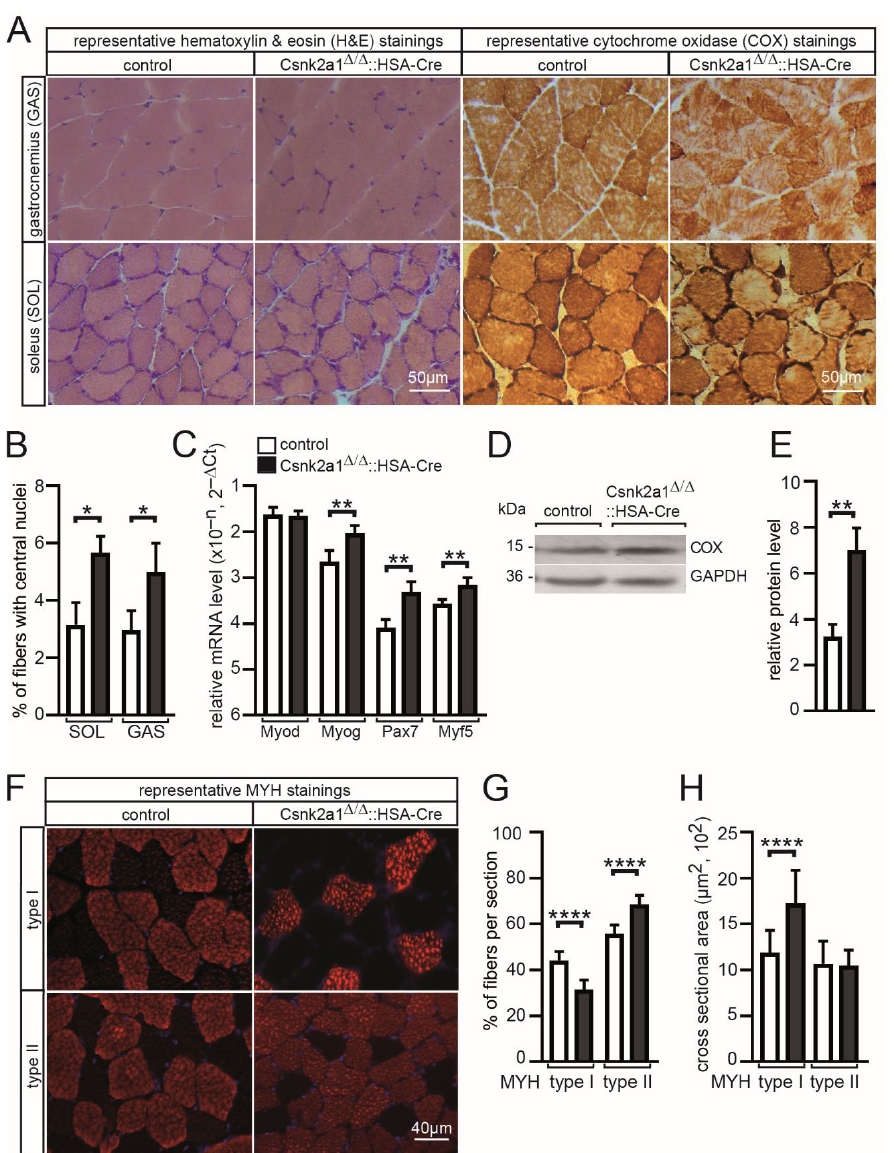
Figure 3. Increased number of central nuclei, cytochrome oxidase, and several myogenic markers are accompanied by changes in muscle fiber distribution and cross-sectional areas in conditional Csnk2a1 knockout mice. ( A ) Hematoxylin/eosin (H&E) and cytochrome oxidase (COX) stains of hind limb muscle cross-sections of control and conditional Csnk2a1 knockout mice. ( B ) Graph presents the number of central nuclei as counted in a representative number of cross-sections of control and conditional Csnk2a1 knockout mice. ( C ) Graph summarizes transcript amounts of myogenic markers Myod1, Myog, Pax7, and Myf5 in tibialis anterior muscle of control and conditional Csnk2a1 knockout mice. ( D ) Image of Western blot ascertains a higher amount of cytochrome oxidase in conditional Csnk2a1 knockout gastrocnemius muscle lysates in comparison with controls. ( E ) Graph presents densitometrical quantification of representative images of Western blots as shown in ( D ). ( F ) Immunofluorescence stainings of soleus muscle cross sections for detection of myosin heavy chain stained fibers. ( G ) Graph summarizes distribution of type I and type II fibers in soleus muscles of conditional Csnk2a1 knockout and control mice. ( H ) Cross-sectional areas (CSA) were measured and are presented against muscle fiber types I and II. All labeling of graph bars represents the genotype of mice as indicated in ( C ). Data are represented as mean ± S.D.; n ≥ 5 mice per genotype. **** p < 0.0001, ** p < 0.01, * p <